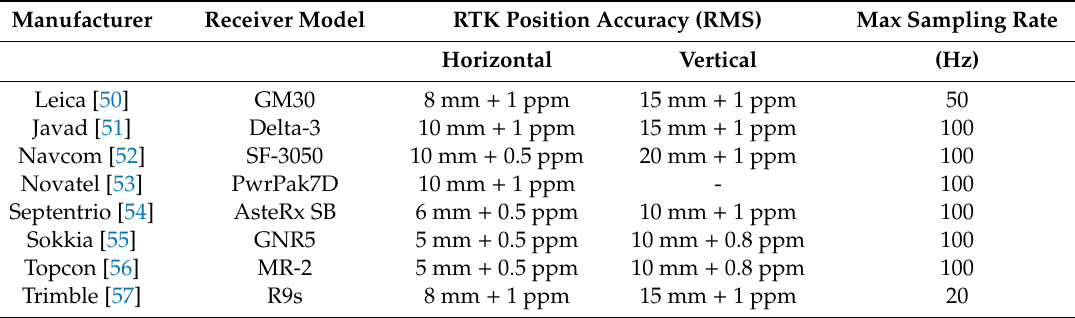
Table 2. GNSS Receivers for RTK positioning based on brochures in